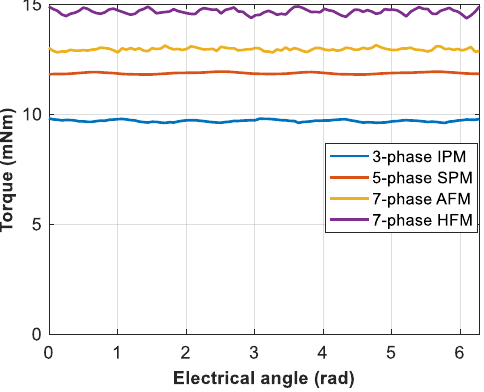
Figure 9. Steady state torque analysis: torque at 120 rpm.